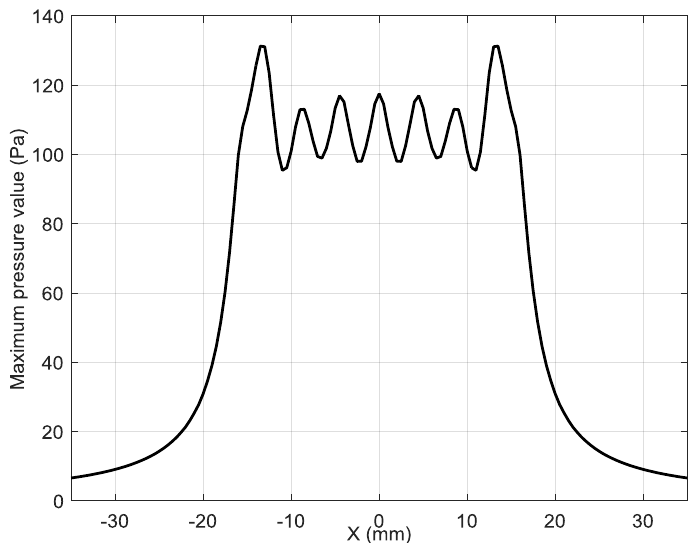
Figure 10. The spatial distribution of the acoustic pressure along the center line of the eight-element array in the plane of the film ( R = 1 mm) when all elements of the array are excited simultaneously.